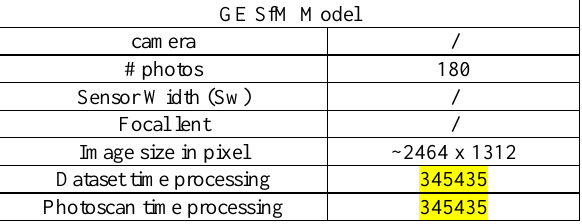
Table 7. GE SfM Model features